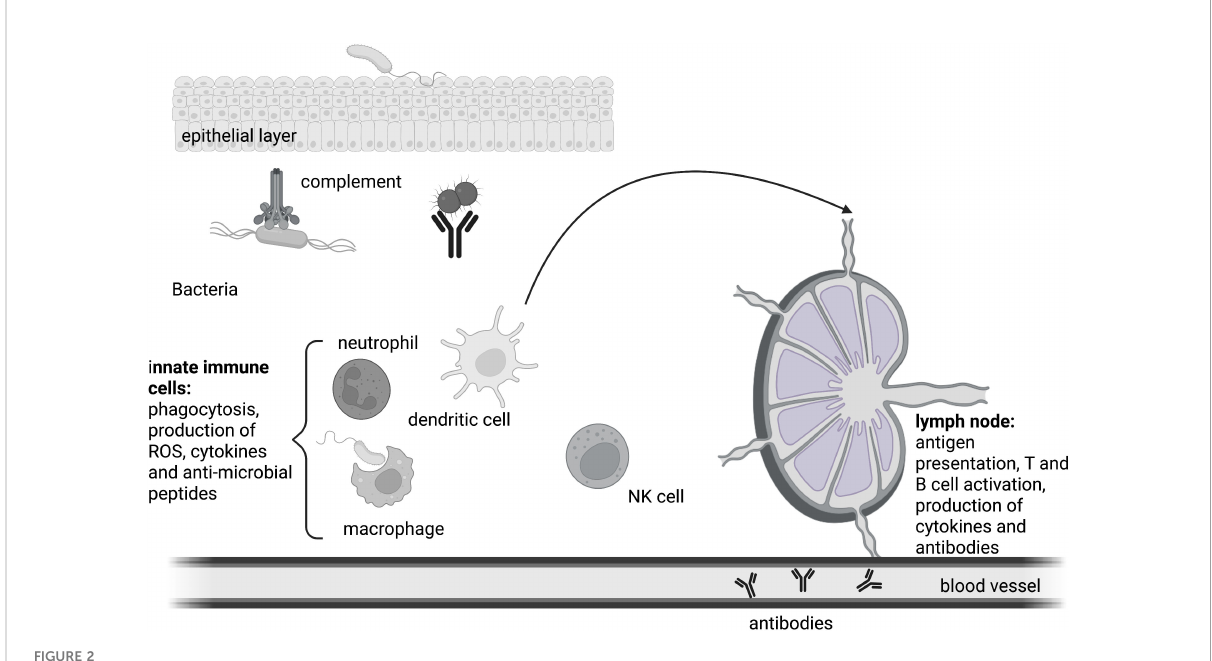
FIGURE 2 The immune response. Innate immune cells coordinate the early phase of the immune response. Mechanical and biological barriers shield the body from the intrusion of pathogens. Humoral as well as cellular mechanisms defend the integrity of the host upon a bacterial infection. Antigens are presented by professional antigen presenting cells to T cells in the lymph node, ultimately resulting in the formation of germinal centers and the generation of class-switched antibodies by B cells. Antibodies also take part in innate humoral responses like